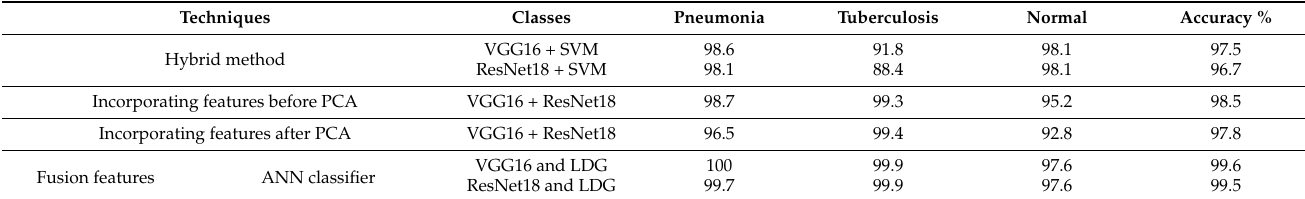
Table 6. Results of the proposed systems in this study for diagnosing pneumonia and tuberculosis and distinguishing between